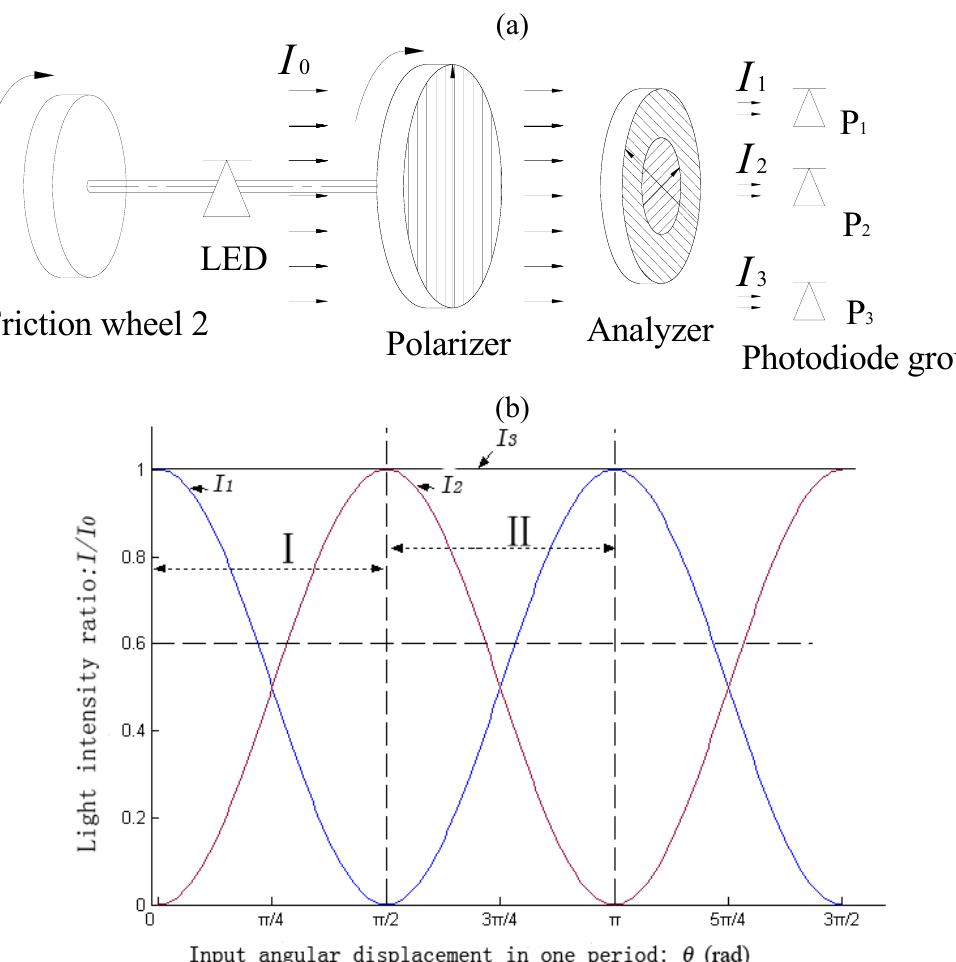
Figure 3. (a) Structure diagram of detecting system 1. (b) Light intensity signals variation rule detected by the detecting system